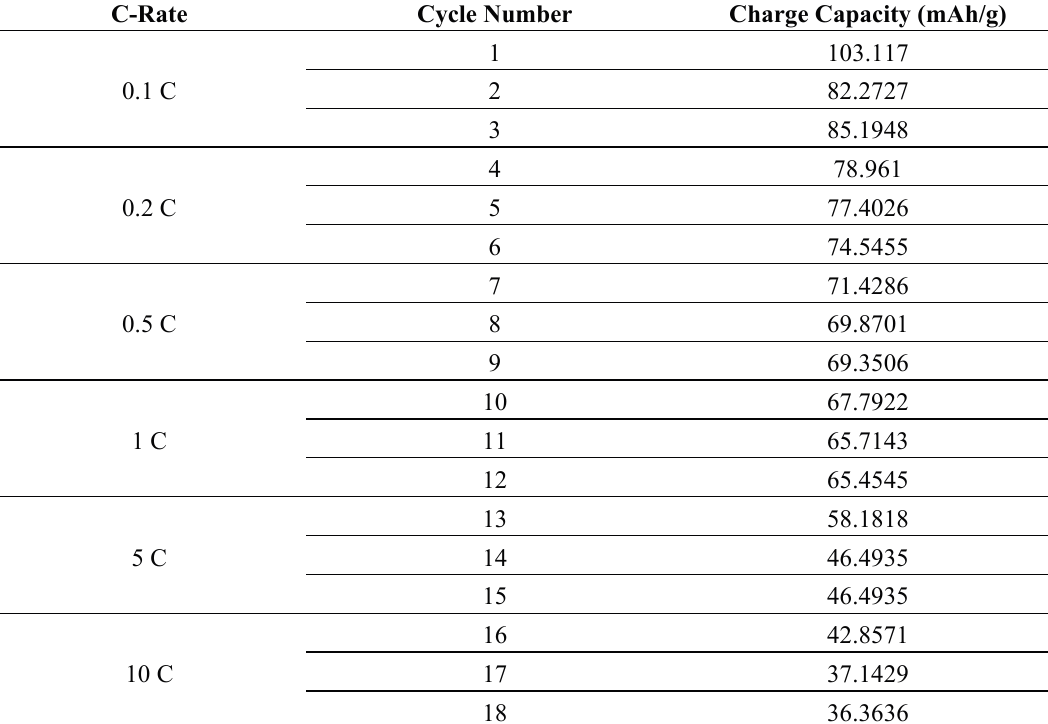
Figure 9. Maximum unit cumulative capacity curve in various cycles of coin cell charge tests. Table 5. Maximum unit cumulative capacity in various cycles of coin cell charge